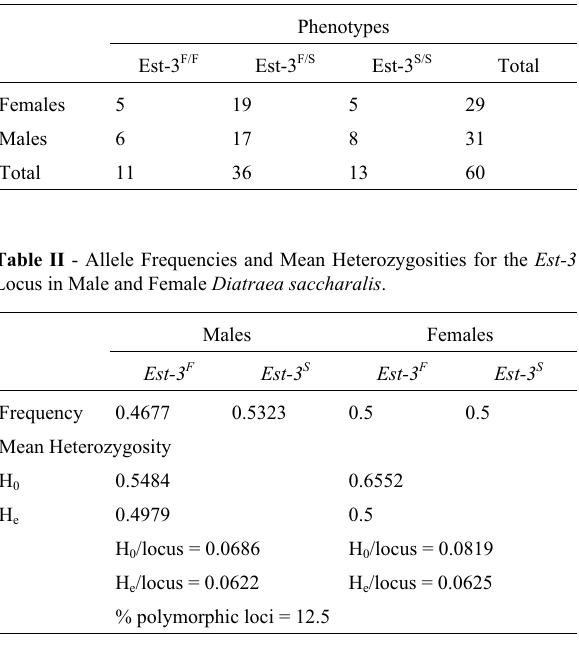
TableI -NumberofMalesandFemalesAnalyzedandtheElectrophoretic Phenotypes of the Est-3 locus in Diatraea saccharalis.